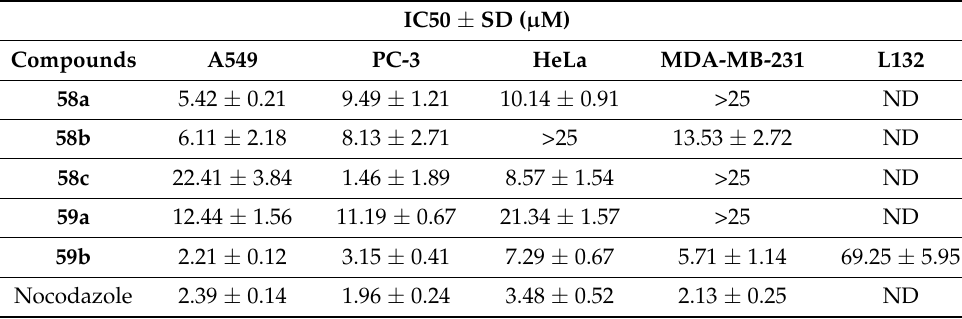
Figure 17. Chemical structures of benzimidazole and cinnamic acid hybrids. Table 3. Antiproliferative activity of compounds 26a – c and 27a – b